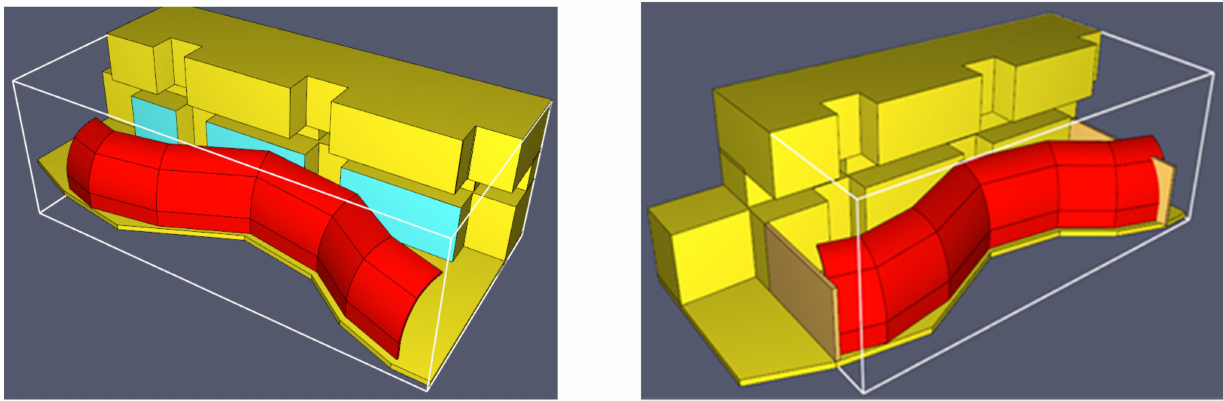
Figure 9. ( On the left ): B configuration with radiant panels arranged on the wall adjacent to the clinics. The panels are marked in blue. ( On the right ): C configuration, geometric model with south and north side